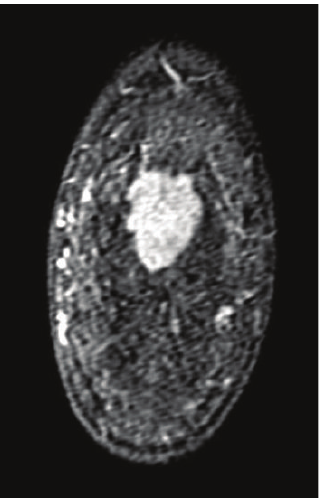
Figure 3: Enhanced MRI revealed a mass of high intensity, but no intraductal spread was detected (coronal